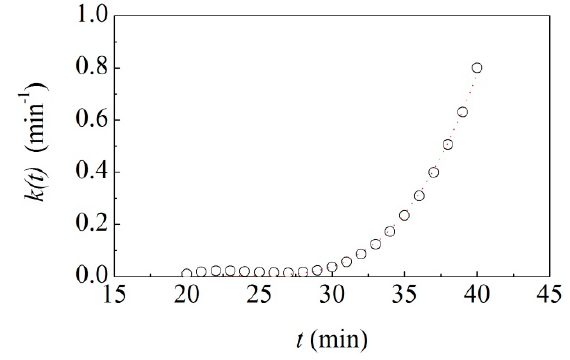
Figure 3. The variation of the rate coe ffi cient. The rate coe ffi cient, k ( t ) , as a function of time t . The best-fitted curve is shown.